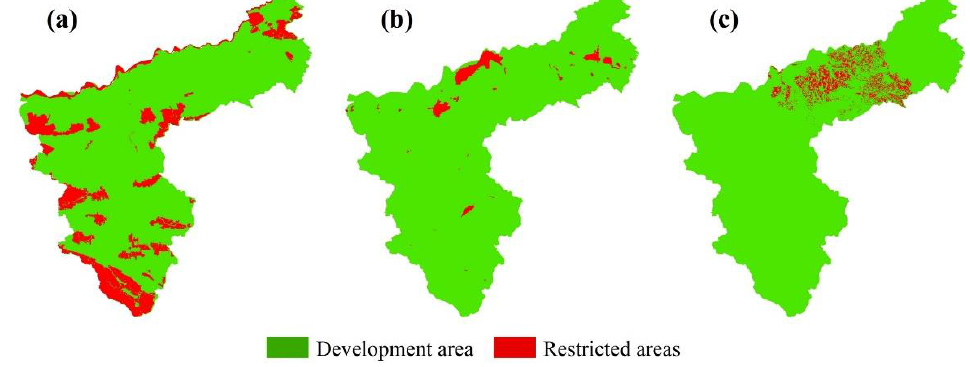
Figure 5. Restricted development areas (( a ), ecological conservation area; ( b ), urban development boundaries; ( c ), permanent prime cultivated land).